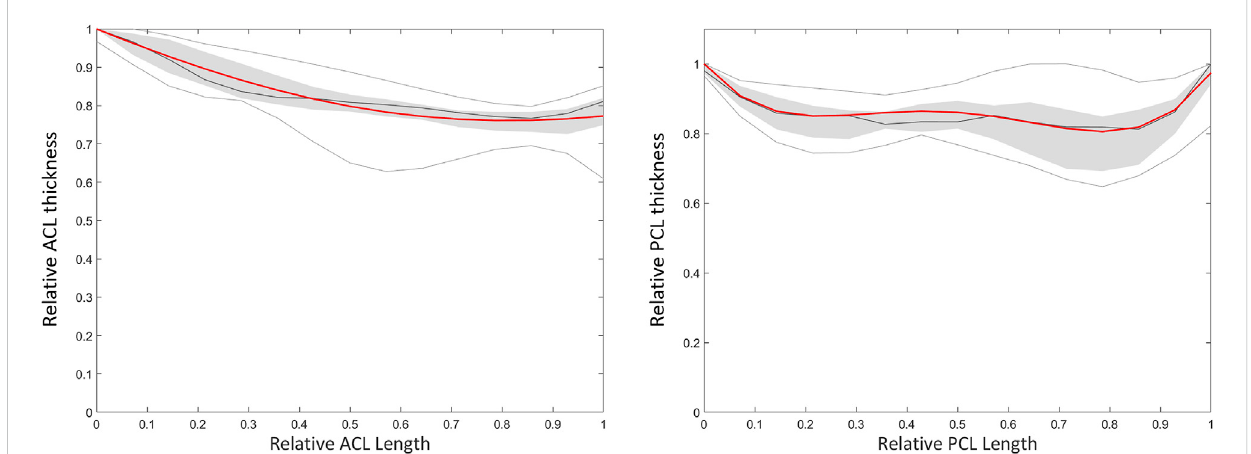
FIGURE 11 Polynomial fi tting for ACLand PCL thickness prediction. Themedian thickness oftheACL (left)and PCL(right) ispresented asthedark greyline.The grey zone represents the values between P25 and P75. The light grey lines represent minimal and maximal values. The red line represents the thickness based on a respectively 2nd and 4th degree polynomial function for the ACL and PCL.